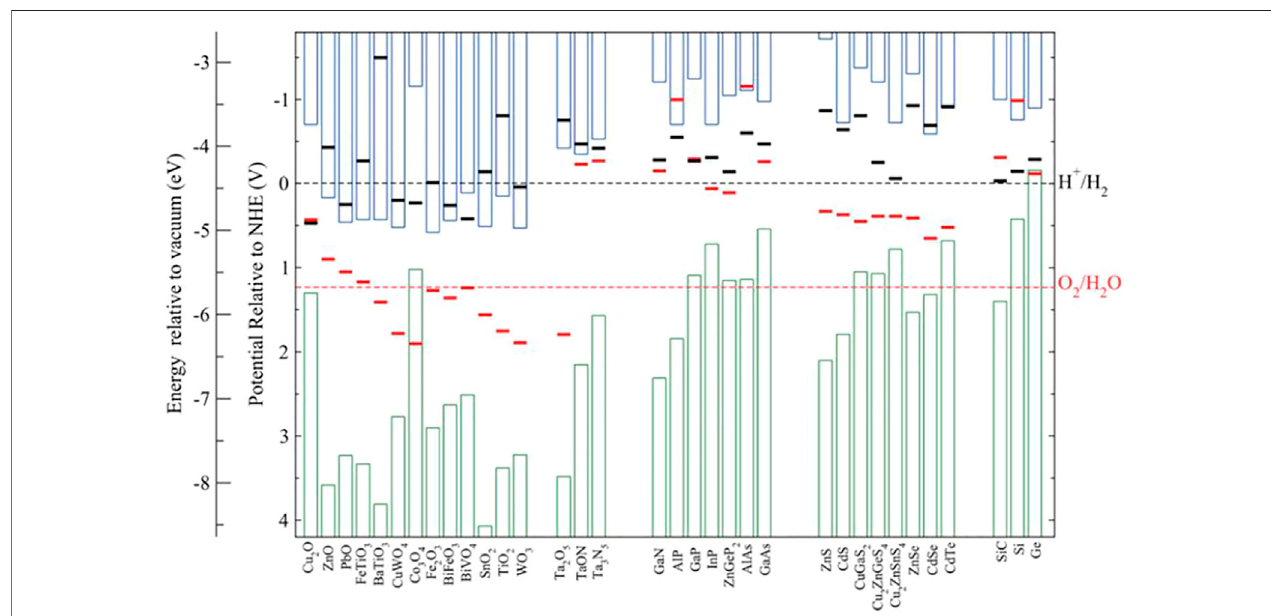
FIGURE1| Calculated ϕ e corr (blackbars)and ϕ h corr (redbars)relativetoNHEandvacuumlevelforvarioussemiconductorphotoelectrodespH=0solutions,ambient temperature 298.15 K, and pressure 1 bar. The blue and green bars represent ϕ CB and ϕ VB , respectively. The black and red dotted lines are the E cathodic and E anodic , respectively. Reprinted (adapted) with permission from Chen and Wang (2012). Copyright 2012 American Chemical